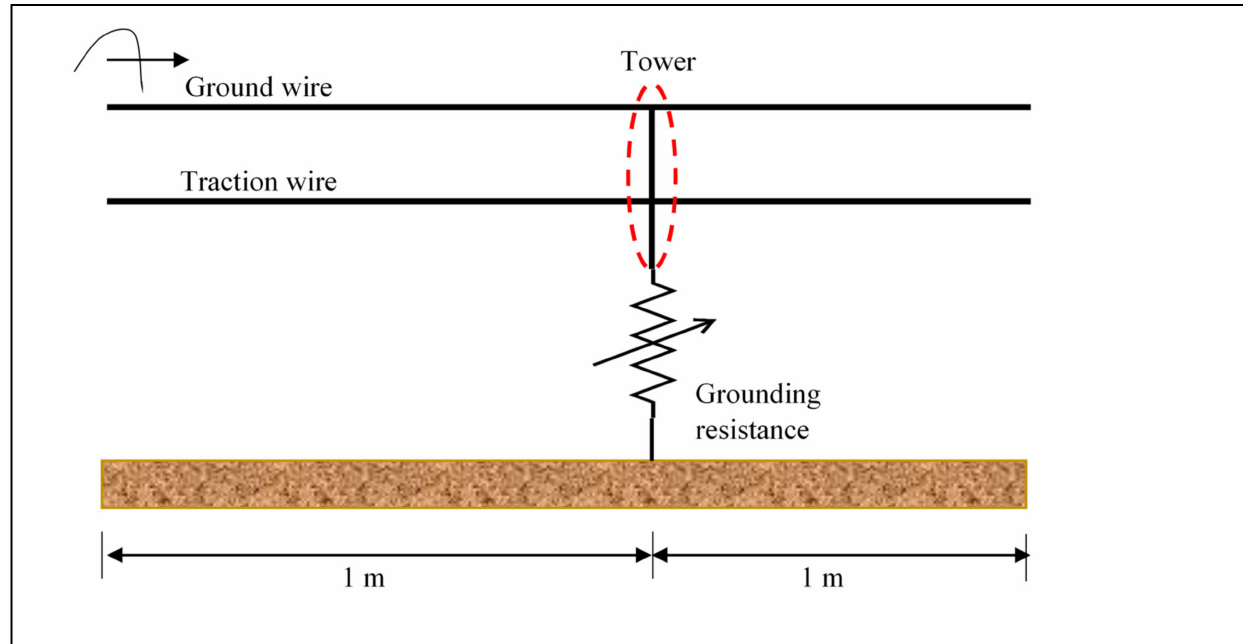
Figure 14. Catenary system high speed railway when struck with lightning